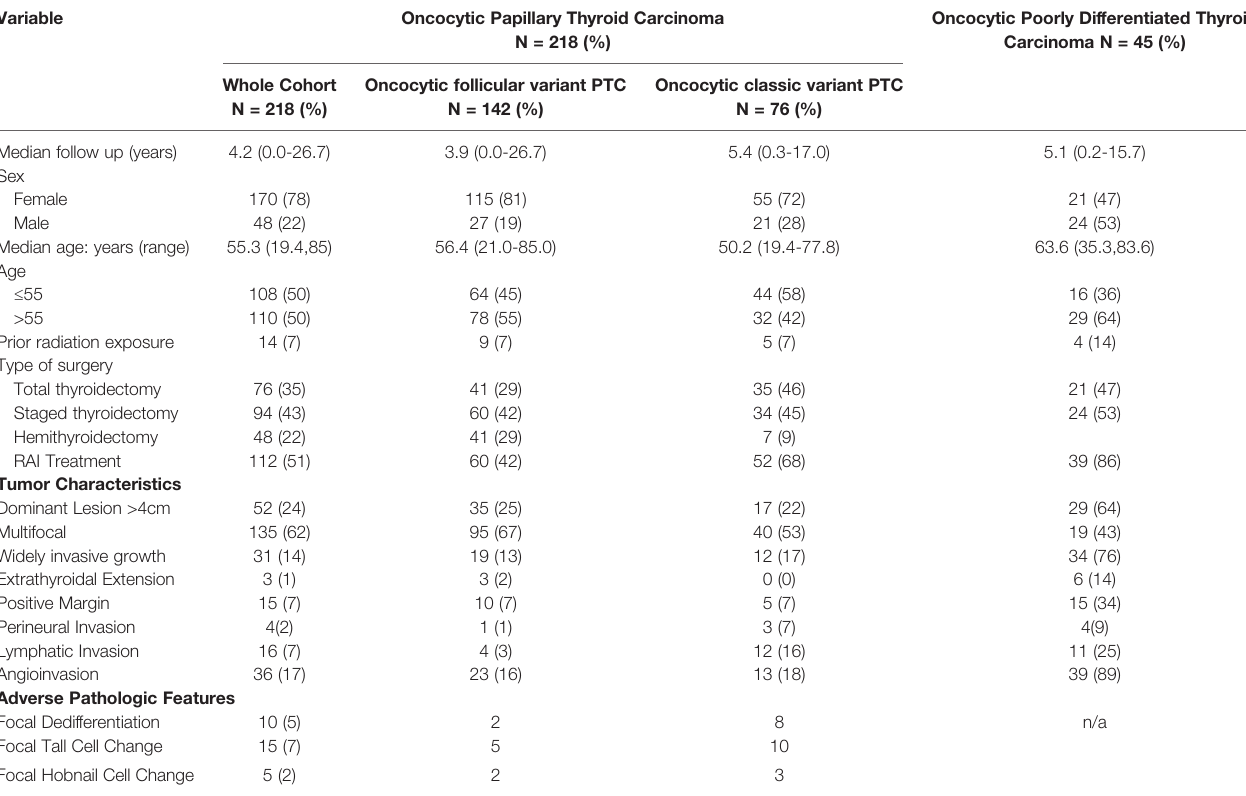
TABLE 1 | Baseline patient and treatment characteristics. Variable Oncocytic Papillary Thyroid Carcinoma